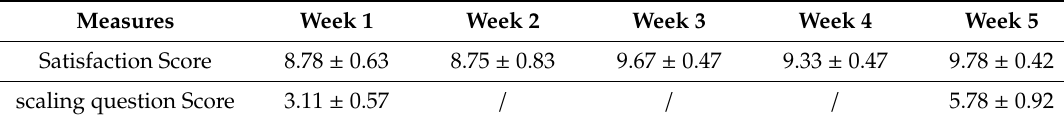
Table 4. Satisfaction Survey Score of Experimental Group.